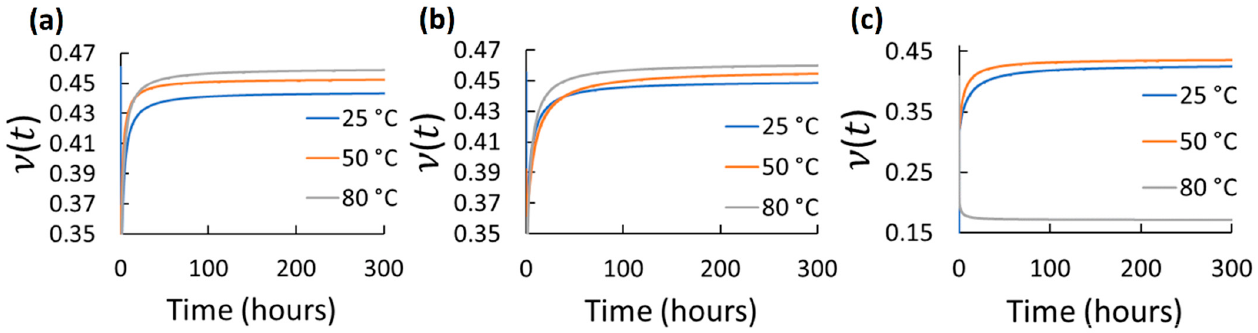
Figure 4. Viscoelastic Poisson´s ratio of EPDM at different temperatures and stress: ( a ) 200 kPa; ( b ) 400 kPa; ( c ) 600 kPa . ( b ) 400 kPa; ( c ) 600